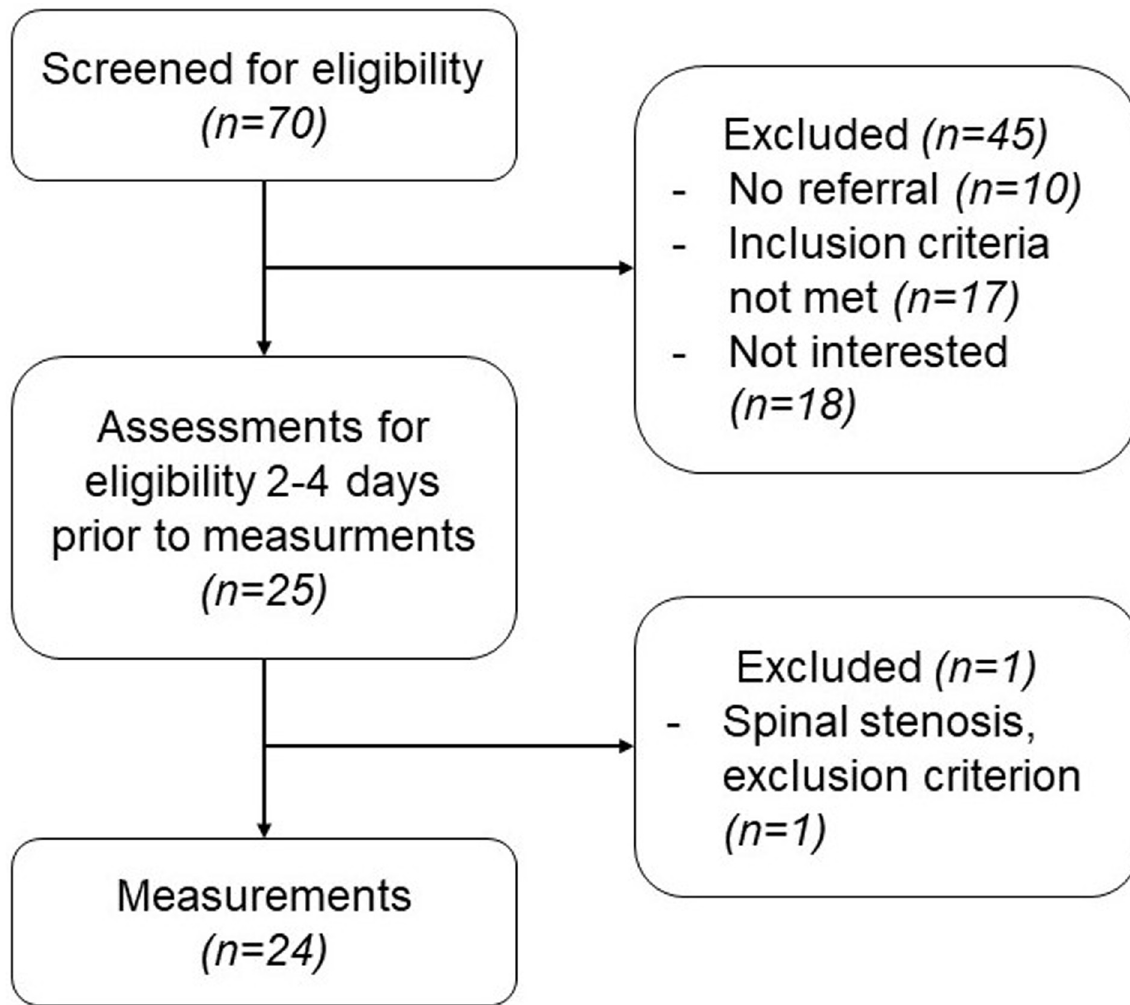
Fig 1. Flow-chart of CNSLBP patients’ recruitment. Process from initial contact with possible participants until participation in the study.